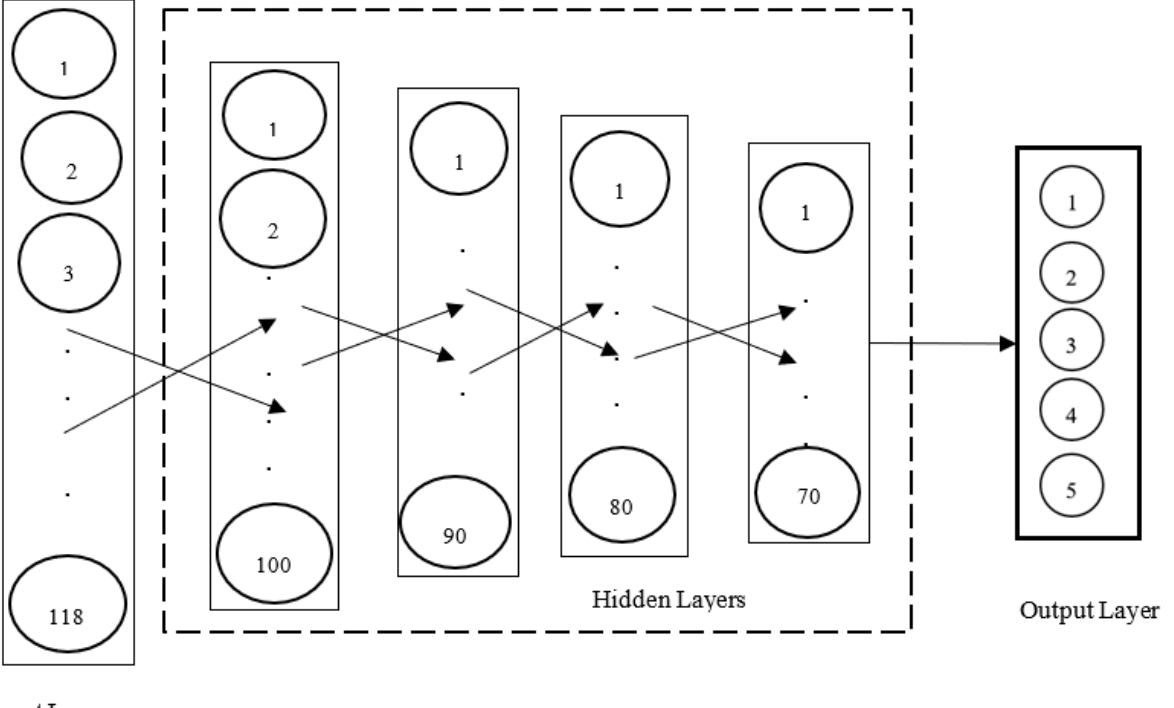
Figure 8. Deep ANN classifier (multinomial classification).